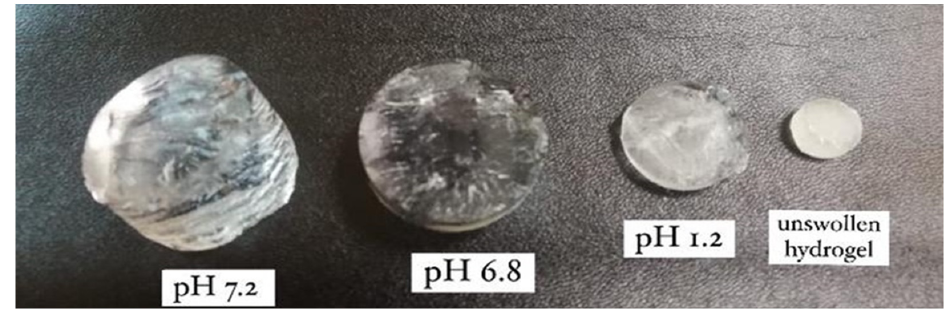
Figure 2. Illustrating the pH-dependent swelling behavior of β -CD hydrogels: greater swelling at basic pH (pH 7.2) compared to pH 6.8 and pH 1.2. basic pH (pH 7.2) compared to pH 6.8 and pH